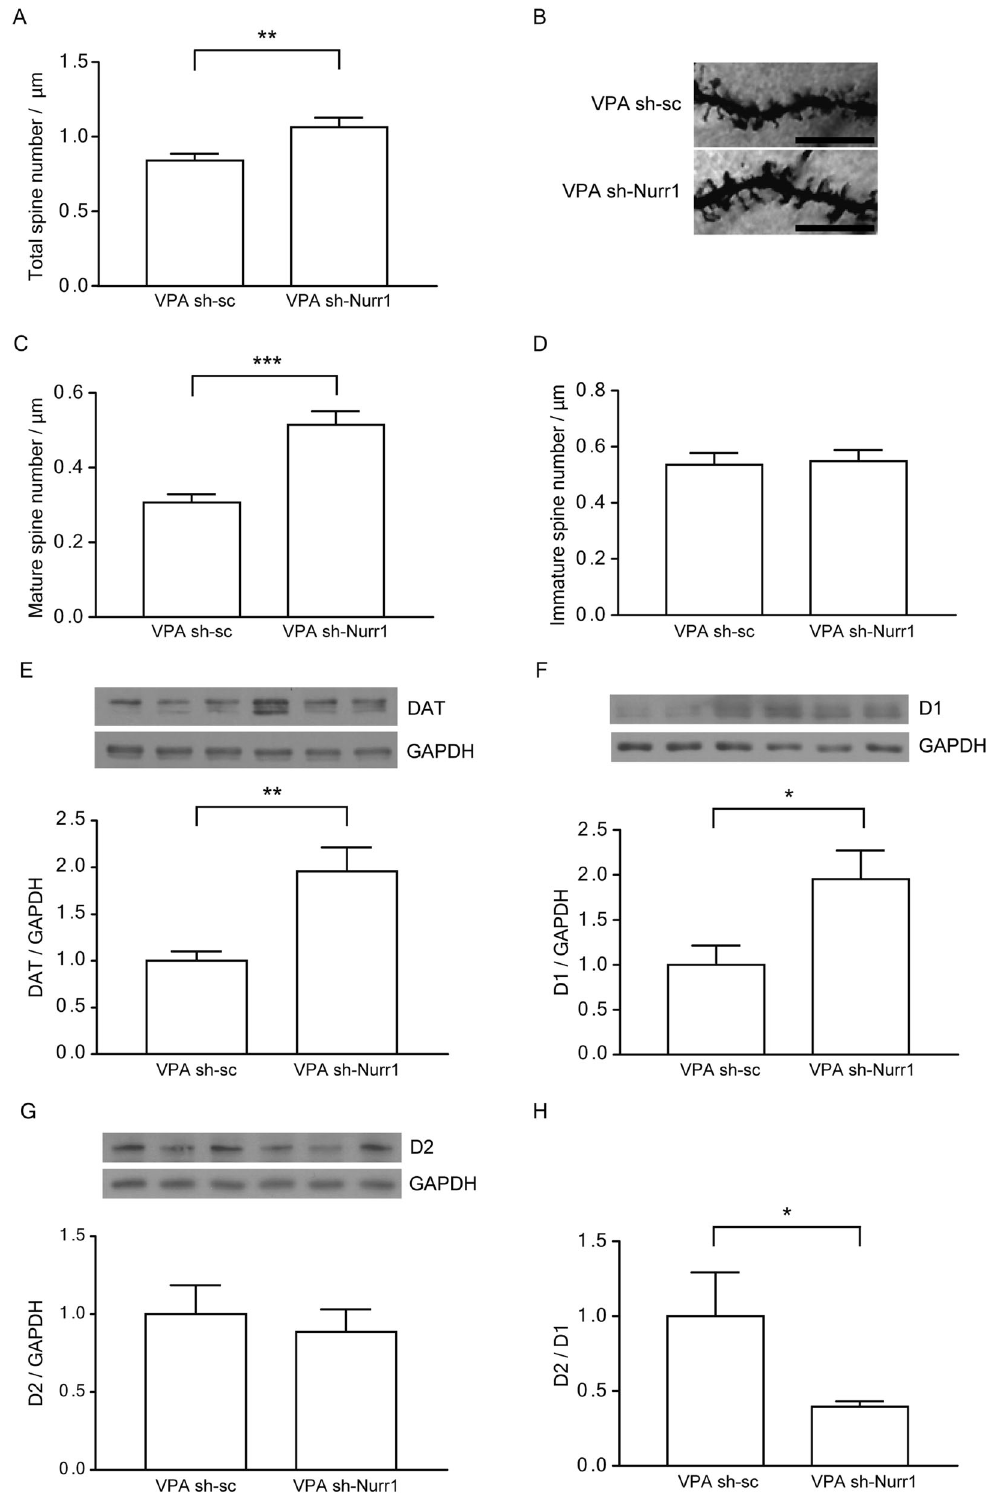
Fig. 4 Lentiviral Nurr1 knockdown in the striatum rescued the abnormalities in dendritic spine density and inputs in the striatum of prenatally VPA-exposed 10-week-old mice. A Quanti fi cation of total dendritic spine numbers/ μ m in VPA sh-sc and VPA sh-Nurr1 mice. B Representative images of Golgi-stained neurons in the DMS from VPA sh-sc and VPA sh-Nurr1 mice. Scale bars represent 10 μ m. C , D Quanti fi cation of mature ( C ) and immature dendritic spine density ( D ) (VPA sh-sc, n = 15; VPA sh-Nurr1, n = 11). n means the number of neurons analyzed. ** p < 0.01, *** p < 0.001 compared to VPA sh-sc mice, unpaired t -test. E – G Representative blots for DAT, D1 and D2 and the densitometric analysis of protein levels of DAT (VPA sh-sc, n = 7; VPA sh-Nurr1, n = 8), D1 (VPA sh-sc, n = 6; VPA sh-Nurr1, n = 8), and D2 (VPA sh-sc, n = 7; VPA sh-Nurr1, n = 8). H The relative expression of D2 compared to D1 (VPA sh-sc, n = 5; VPA sh-Nurr1, n = 8). * p < 0.05, ** p < 0.01 compared to VPA sh-sc mice, unpaired t